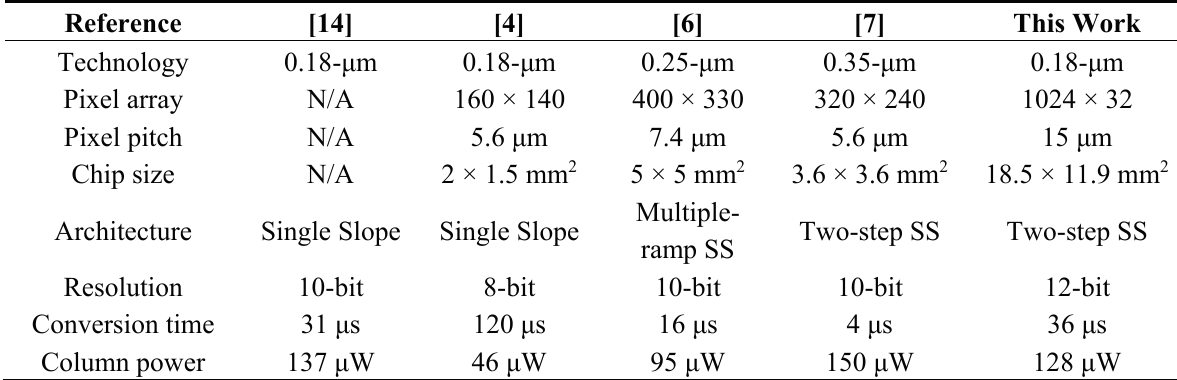
Table 3. Comparison with other types of the column-parallel